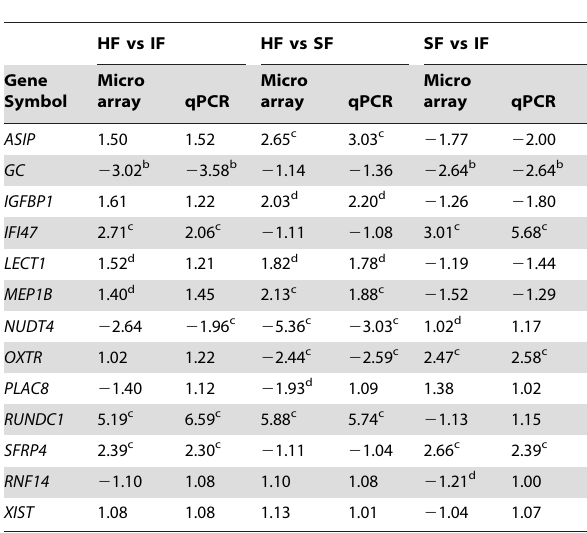
endometria of HF as compared to IF (Table 3 and Table S4) and HF as compared to SF heifers (Table 4 and Table S5).